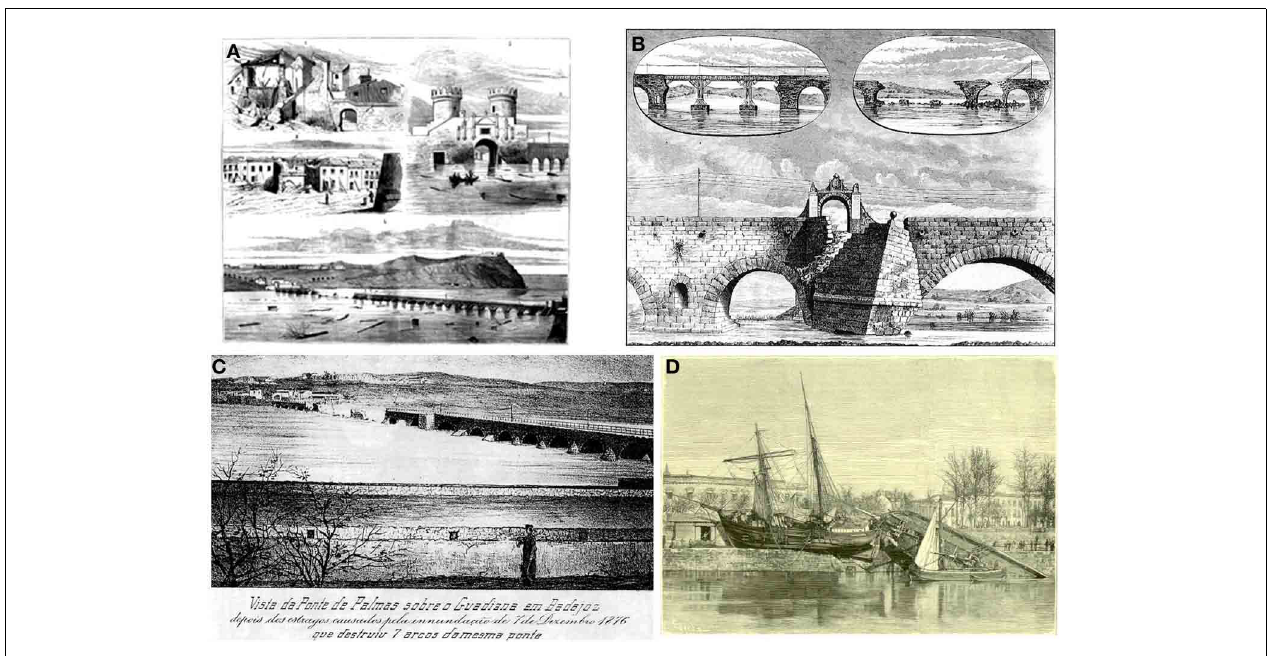
FIGURE 3 | Some engravings on the floods of December 1876. (A) four scenes from the city of Badajoz flooded by the waters of the Guadiana, including a picture of the importantly damaged Bridge of Palmas; (B) damages in the great Roman Bridge in the city of Mérida caused by the rising of